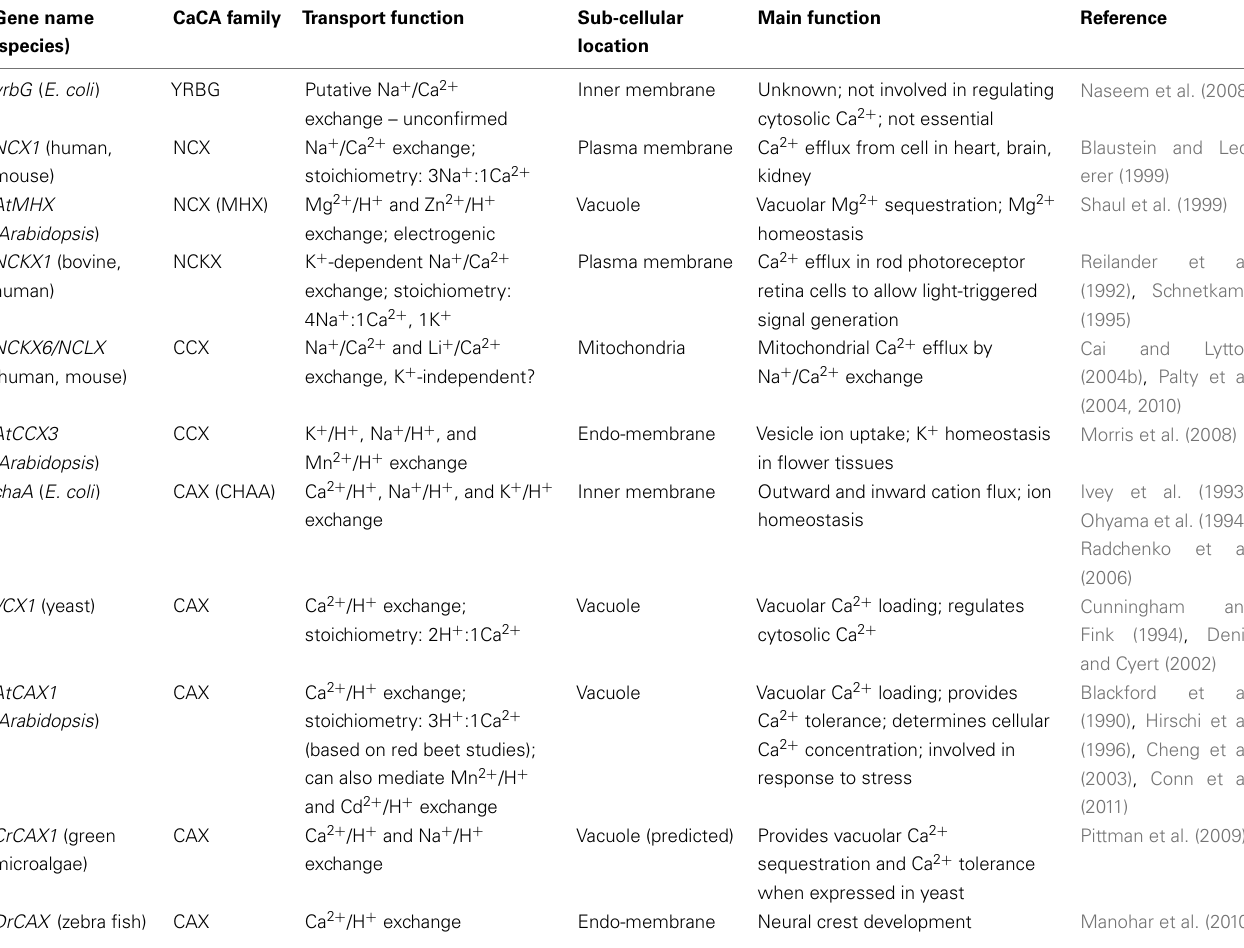
Table 2 | Summary of the major properties and functions of selected CaCA